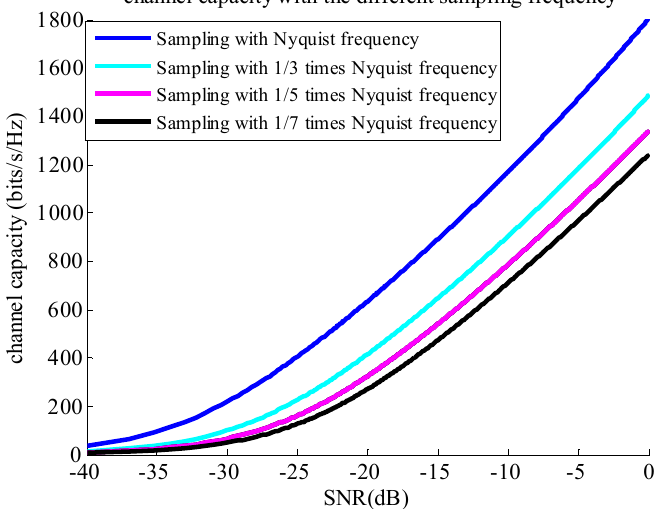
Figure 3. Channel capacity against signal-to-noise ratio (SNR) at different sampling frequencies. As the sampling frequency decreases, channel capacity decreases.